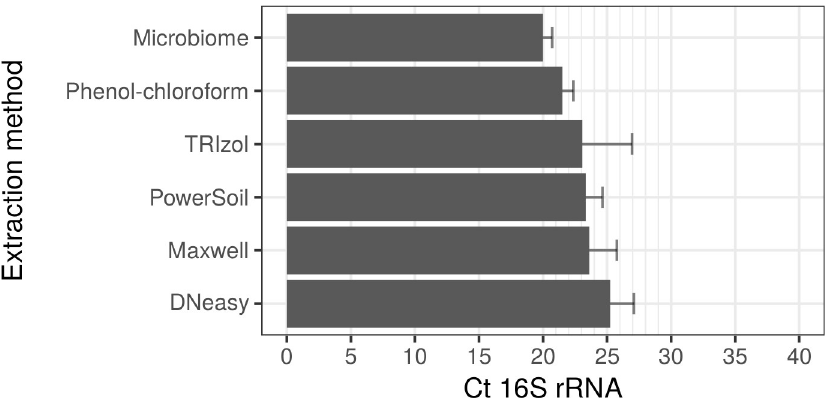
Fig 3. Ct values for M . leprae target (16S rRNA) amplified by qPCR from infected mouse footpad tissue extracted by different DNA extraction procedures. Data are displayed as mean plus standard deviation (SD) from batches processed independently. All kits were analyzed in triplicate with the exception of Microbiome, which was analyzed in